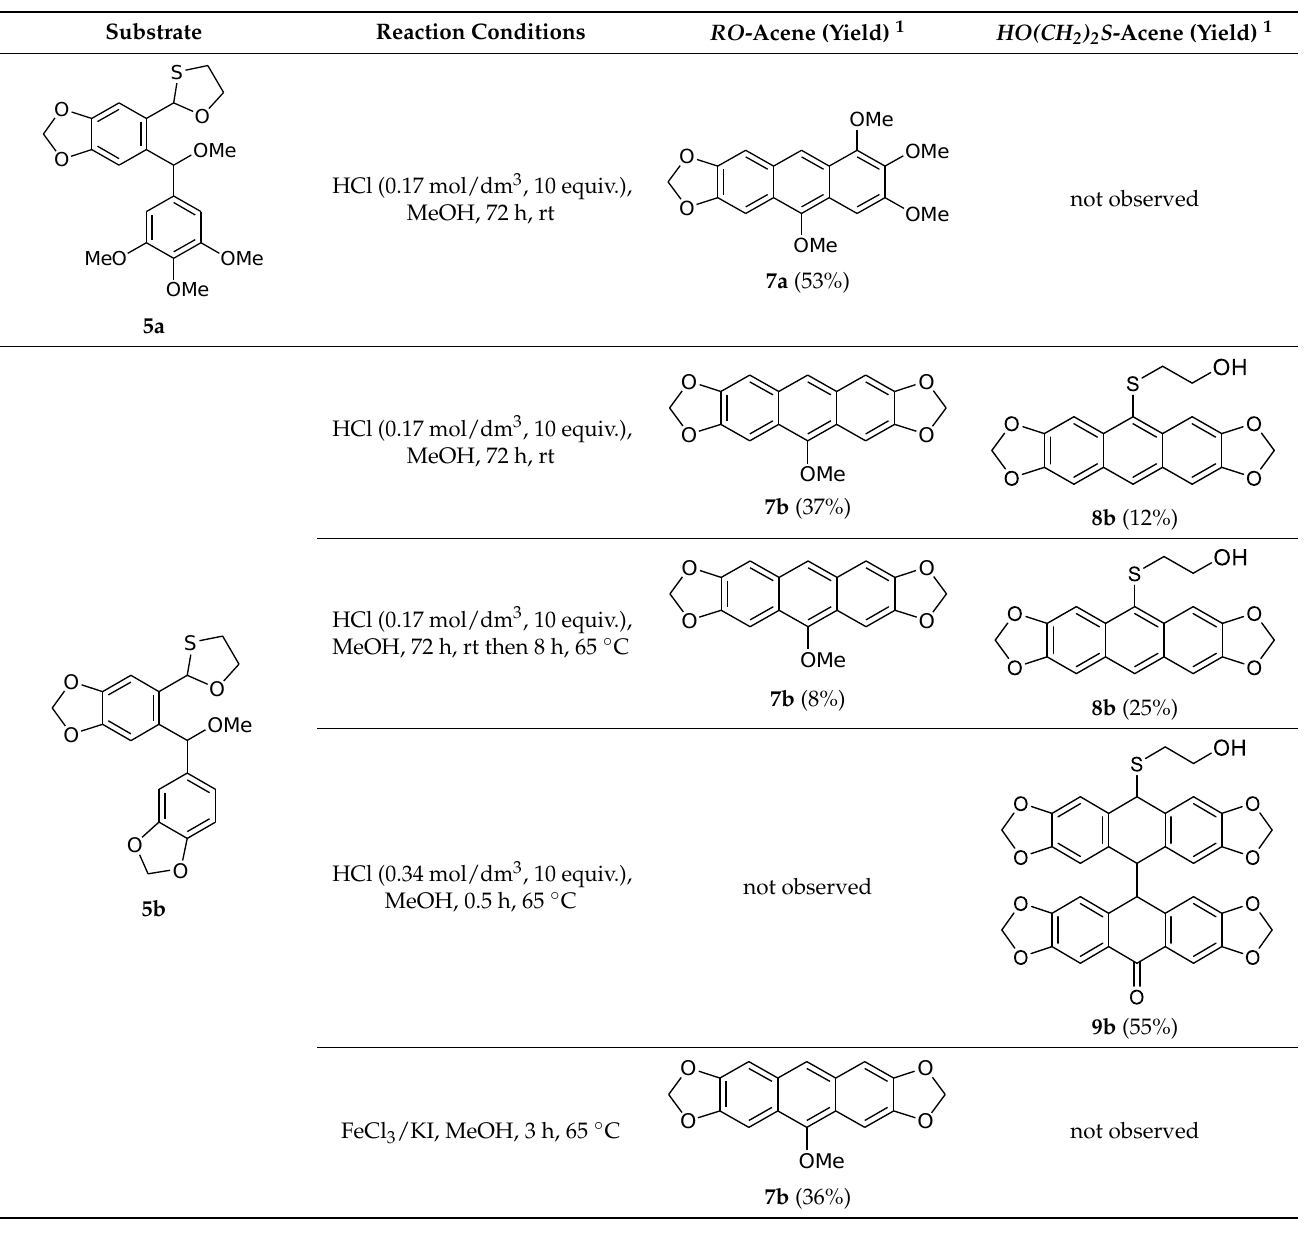
Table 1. A comparison of the cyclization results of ethers 5 and 12 .